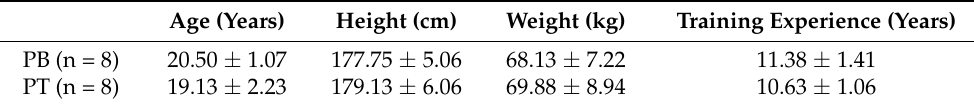
Table 1. The demographic characteristics of the